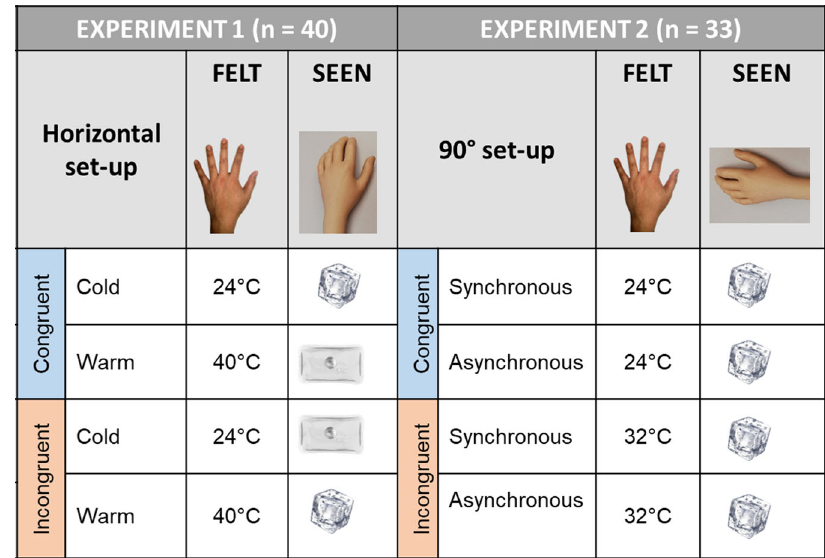
Fig. 4 Summary of the experimental conditions across the two experiments. The felt touch on the real hand was delivered at cold (24 °C), neutral (32 °C) or warm (40 °C) temperatures. The touch on the rubber hand was delivered with a fake ice cube or a hand